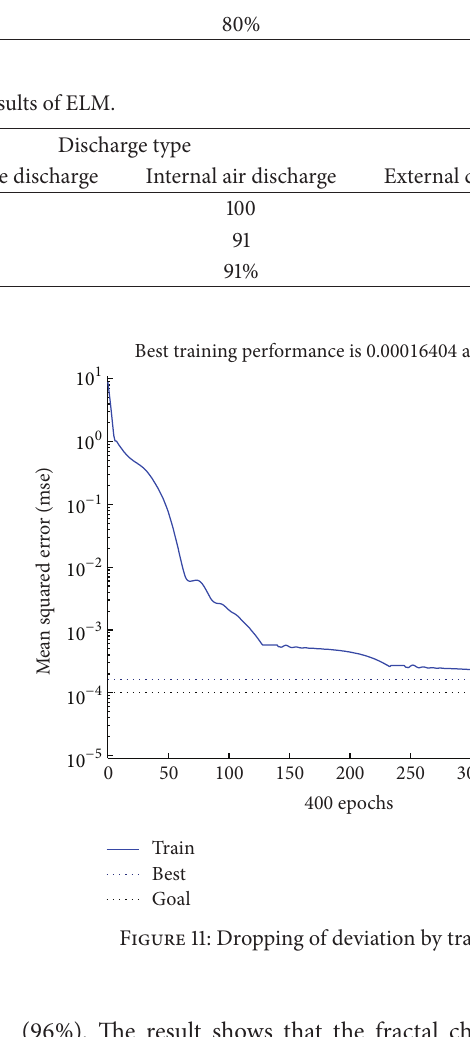
(96%). The result shows that the fractal characteristics of partial discharge signals have a strong ability to describe pattern and the recognizer is